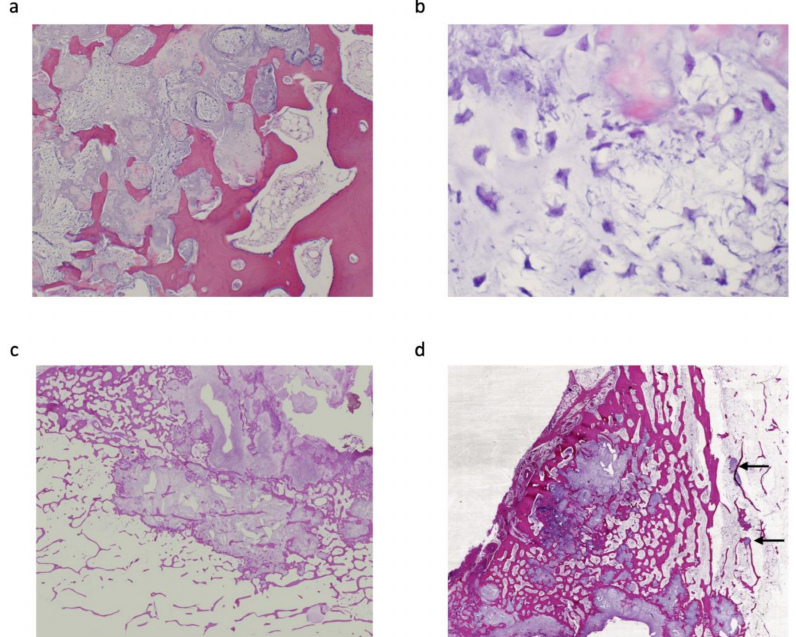
Figure 2. Histopathological sections (haematoxylin & eosin stain) from Case 3; a grade II periosteal chondrosarcoma. ( a ) Section showing proliferation of atypical chondrocytes, embedded in a cartilagi- nous matrix, accompanied by myxoid changes. Permeation of the cortical bone is also prominent ( × 40). ( b ) Tumour cells with hyperchromatic nuclei embedded in the myxoid matrix ( × 300). ( c ) Atyp- ical chondrocytes invading the medullary cavity ( × 20). ( d ) Skip lesions from the periosteal tumour invading the medullary cavity (black